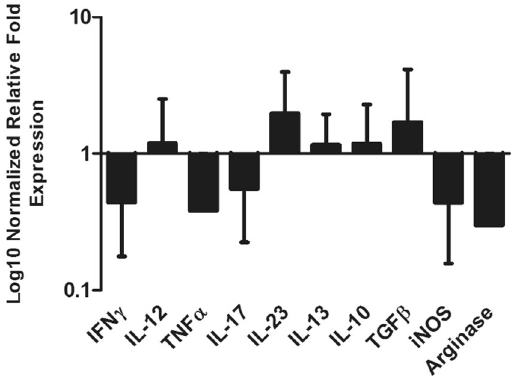
Figure 4. Analysis of relative quantitative cytokine gene expression within the cells of the peritoneal fluid, represented by normalized relative fold expression on log10 scale. Immune marker transcript abundance of the infected group was normalised against the abundance of the respective transcripts in the uninfected group. Transcript abundance of the uninfected group (not shown on graph) is equal to 1. Data represents mean + SEM of fold changes in target transcript abundance relative to three house-keeping genes: β -actin, B2M and GAPDH. Each bar represents data from five biological replicates; statistical analyses were performed using One Way ANOVA with Tukey’s post hoc tests, comparing the data from the uninfected with infected samples, which showed no statistical differences based on animal variation within each